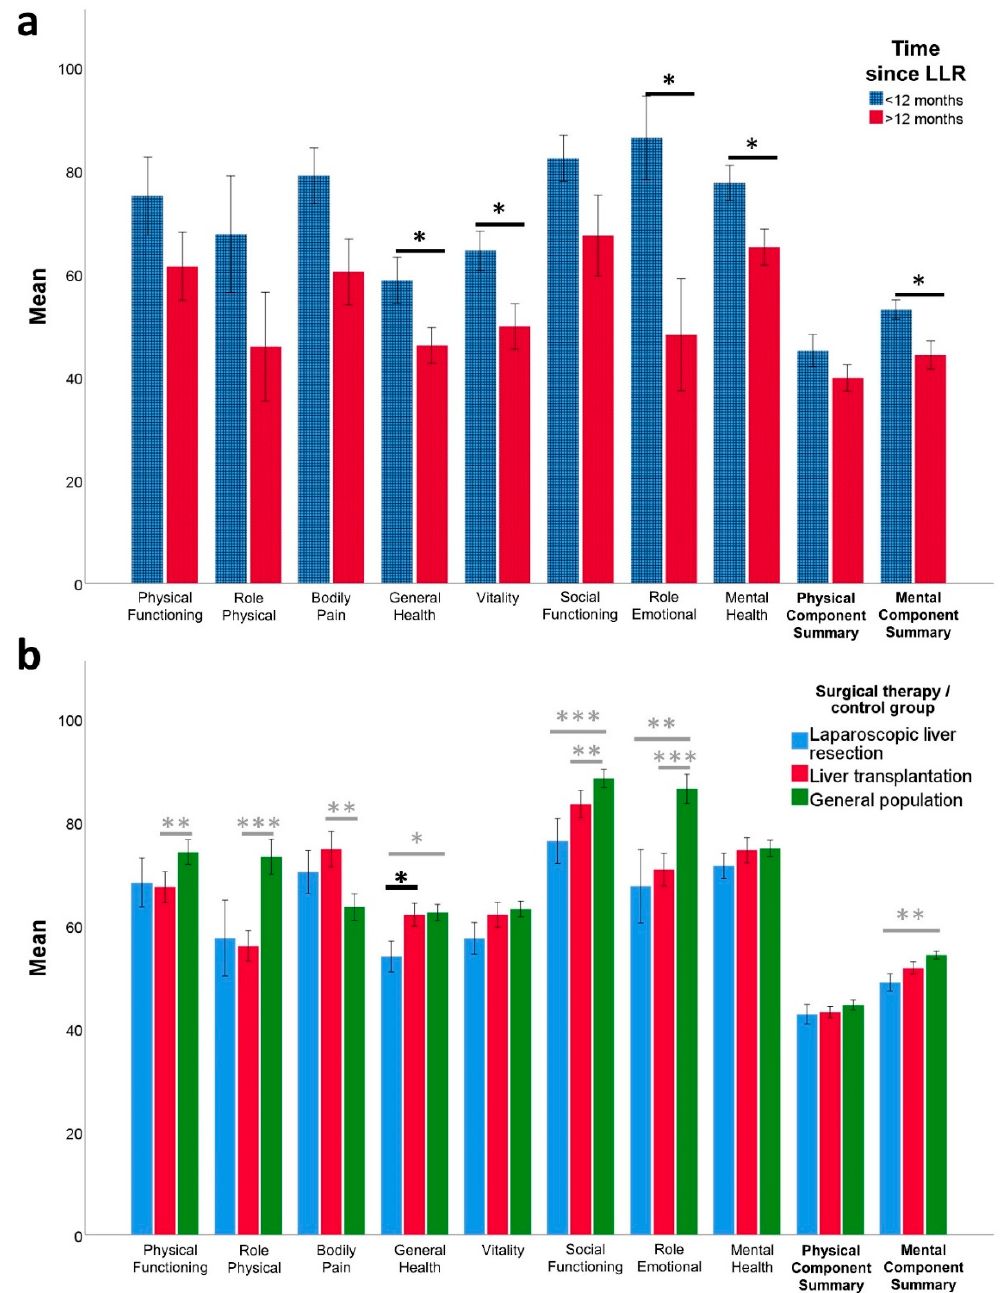
Figure 2. Health-related quality of life measured with Short Form 36 (SF-36) in patients with hepatocellular carcinoma (HCC) after undergoing laparoscopic liver resection (LLR). Error bars = standard error of the mean. * p < 0.05, ** p < 0.01, *** p < 0.001; ( a ) Health-related quality of life (SF-36) according to the time between LLR and completion of the questionnaire; ( b ) Comparison of health-related quality of life (SF-36) of HCC patients after LLR and orthotopic liver transplantation and the German general population (matched for age and gender). Differences between HCC patients after either surgical therapy and the general population are labeled in grey; differences between LLR and OLR are labeled in